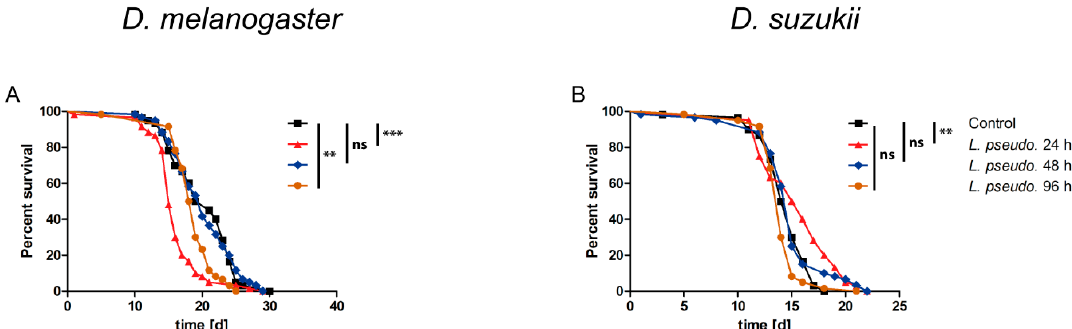
Figure 4. Survival curves for the oral administration of Leuconostoc pseudomesenteroides extracts to ( A ) Drosophila melanogaster and ( B ) D. suzukii . Adult flies (3–10 days old) were starved for 5–6 h before L. pseudomesenteroides extracts (12 droplets, each 3 µL) were presented for 2–3 h. The extracts were